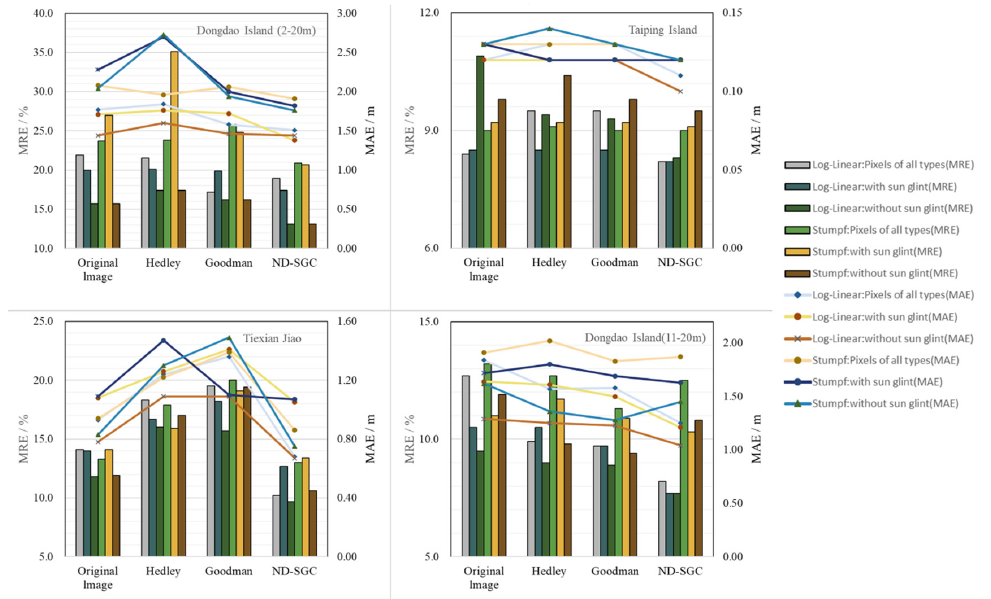
Figure 13. Water depth inversion accuracy of all types of pixels, glint pixels and glint ‐ free pixels before and after sun glint correction. The bar chart represents MRE, and the line chart represents MAE.